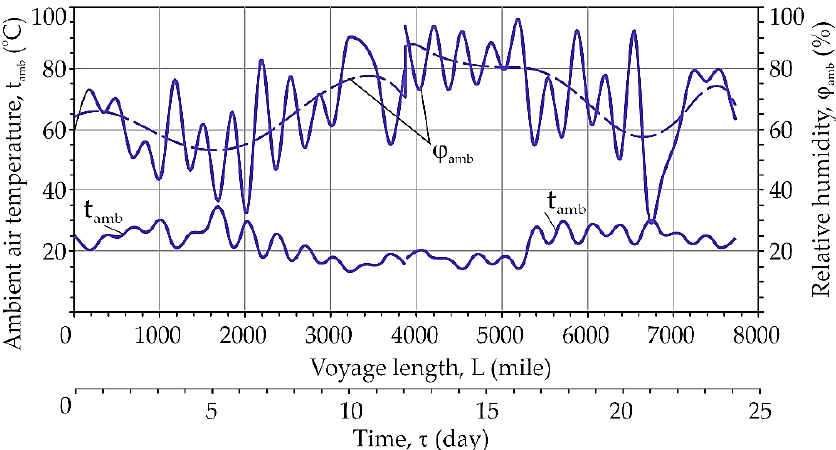
Figure 9. Ambient air temperature t amb and relative humidity φ amb variations on the voyage line